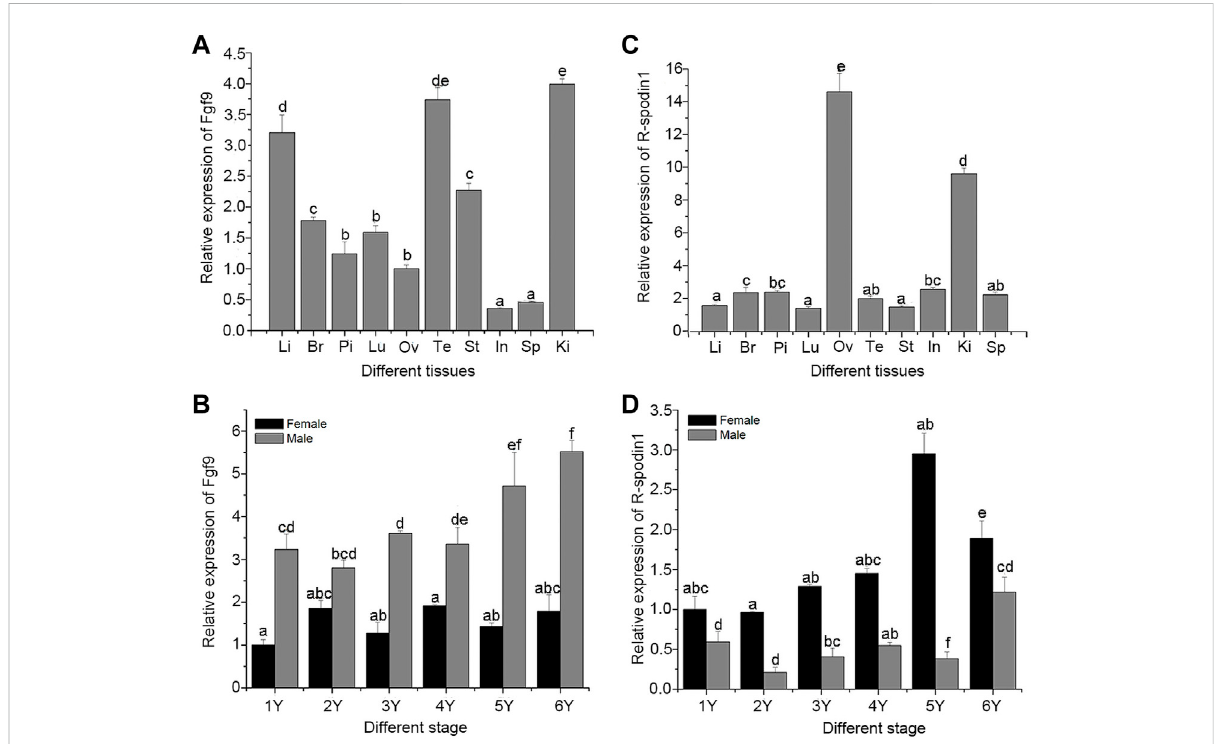
FIGURE 1 Expressionof fgf9 and rspo1 gene:expressionanalysisoffgf9 (A) and rspo1 (B) invarioustissuesbyqRT-PCR;expressionanalysisoffgf9 (C) and rspo1 (D) in developing gonads by qRT-PCR. Tissue from three individuals and each reaction was repeatedthree times. Bars with different letters are signi fi cantly different ( p < 0.05). Li, Liver; Br, Brain; Pi, pituitary; Lu:Lung; Ov, Ovary; Te, Testis; St, Stomach; In, Intestinal; Ki, Kidney; Sp,